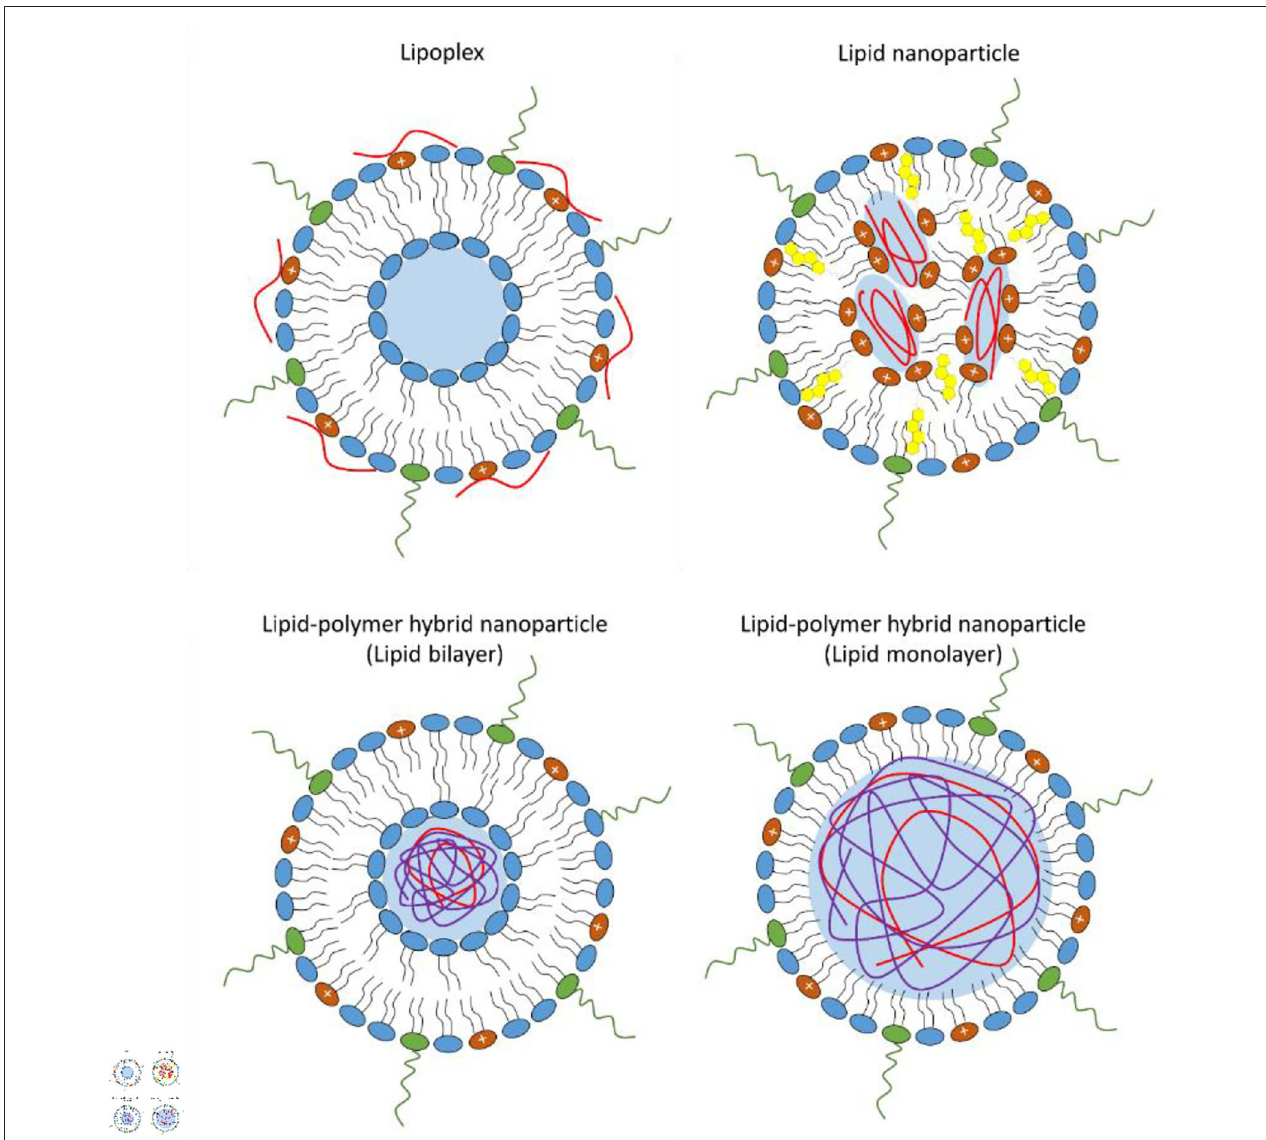
FIGURE 1 | Schematic representation of the different types of lipid-base nanovectors: lipoplex, lipid nanoparticle, lipid-polymer hybrid nanoparticle where the lipid shell can be organized as a bilayer or